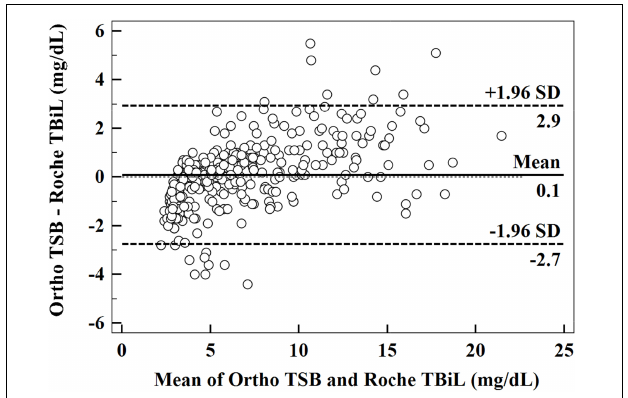
FIGURE 2 | Bland–Altman plot illustrating the relationship between the difference in Ortho TSB and Roche TBiL and the mean of the two sets of data.